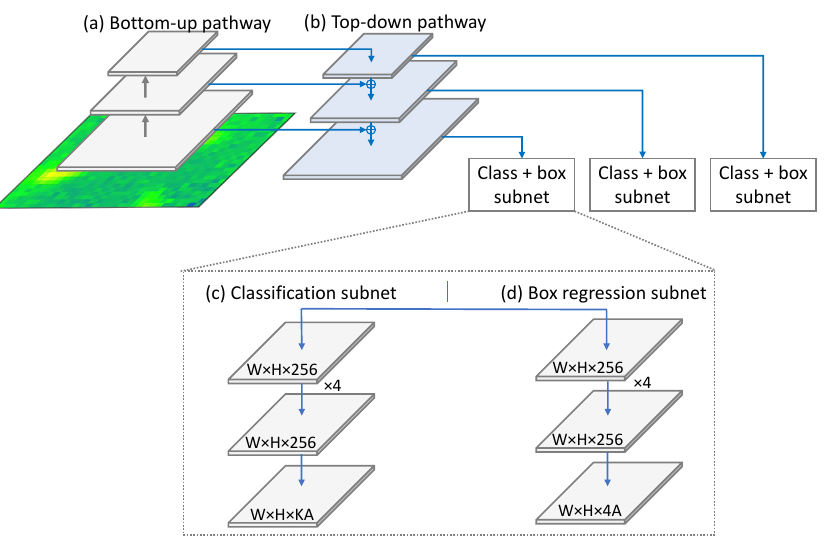
Figure 12. RetinaNet’s simplified architecture. This network is composed of four parts: ( a ) bottom-up pathway, ( b ) top-down pathway, ( c ) classification subnet and ( d ) anchor regression